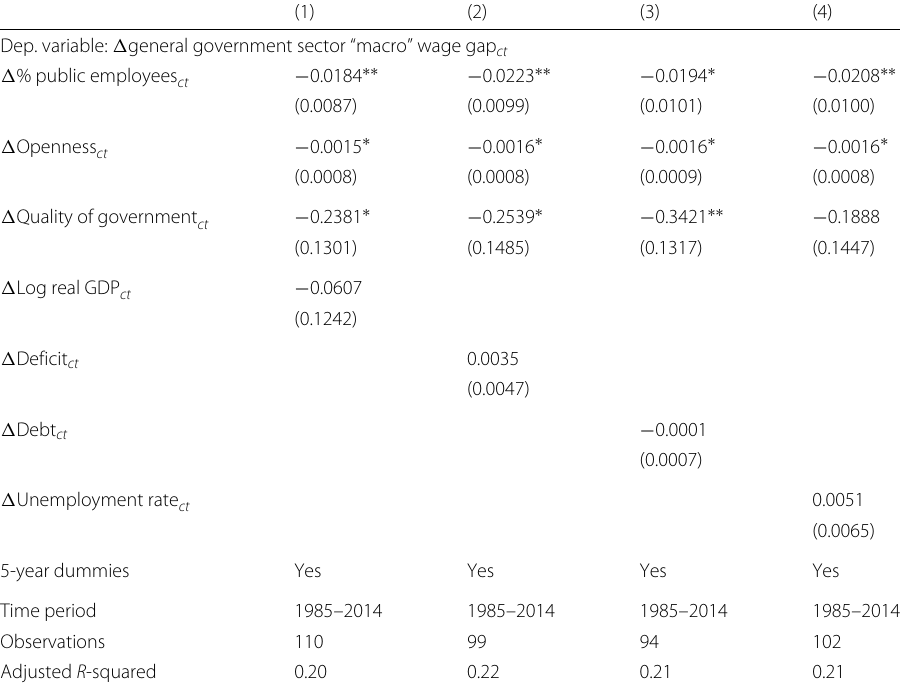
Table 6 Long-run determinants of the public pay gap: robustness (1) (2) (3)